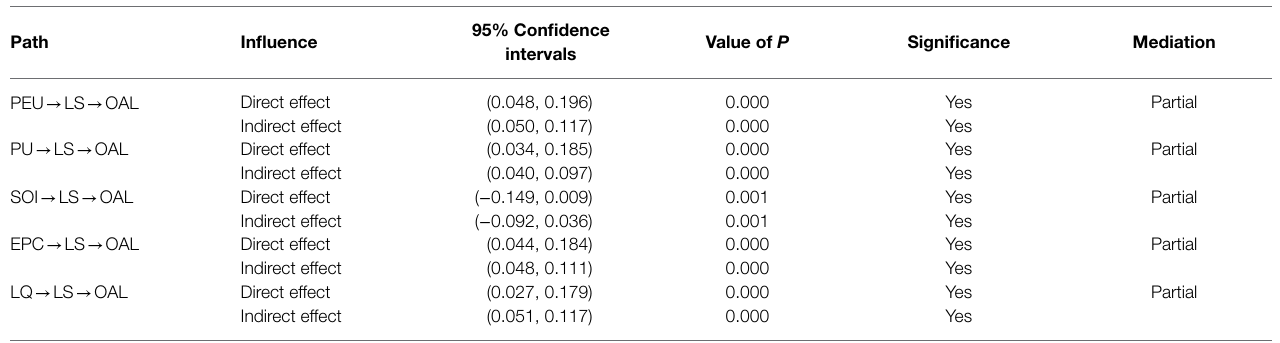
TABLE 5 | Mediation